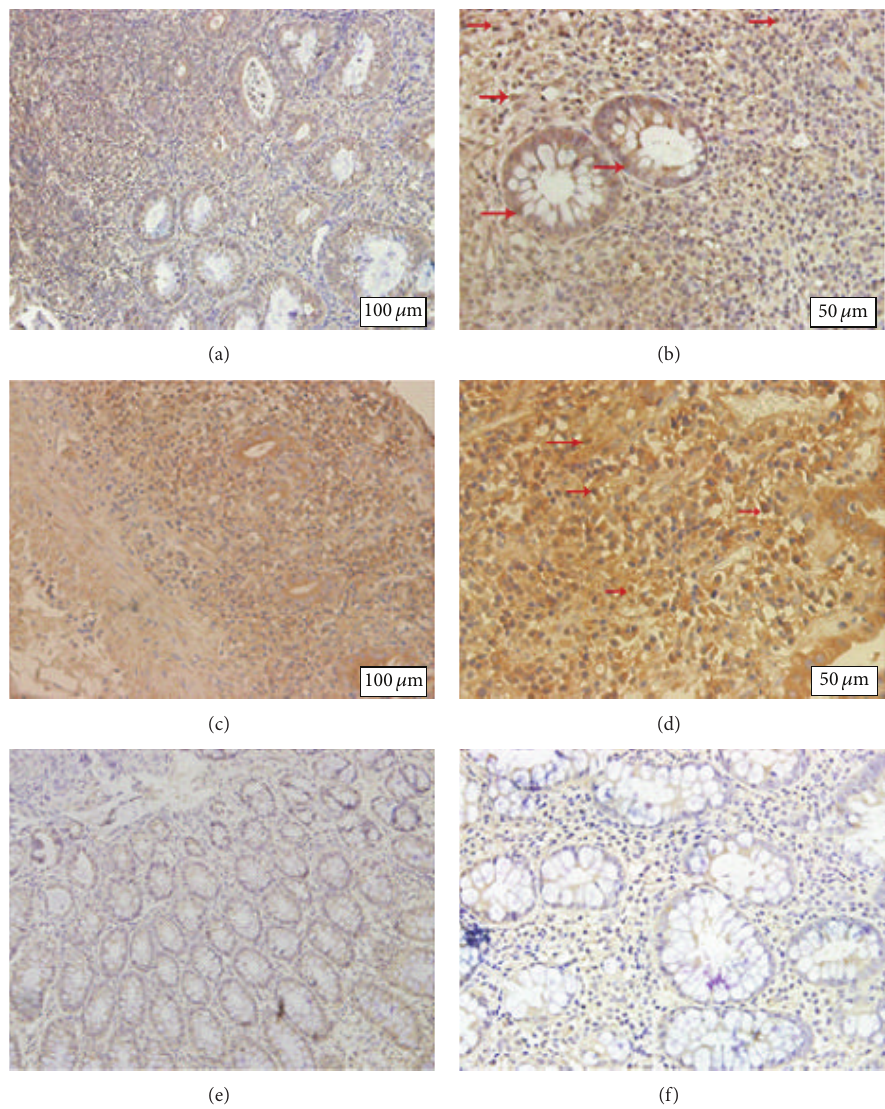
Figure 5: Photomicrographs of immunostaining for IL-37 in patients with UC (a and b), patients with CD (c and d), and control subjects (e and f). IL-37 was expressed by both immune and epithelial cells (a–d), and normal tissue had IL-37 expression, though with relatively small amount (e and f). Besides strong cytoplasmic staining, few single lamina propria mononuclear cells showed nuclear expression of